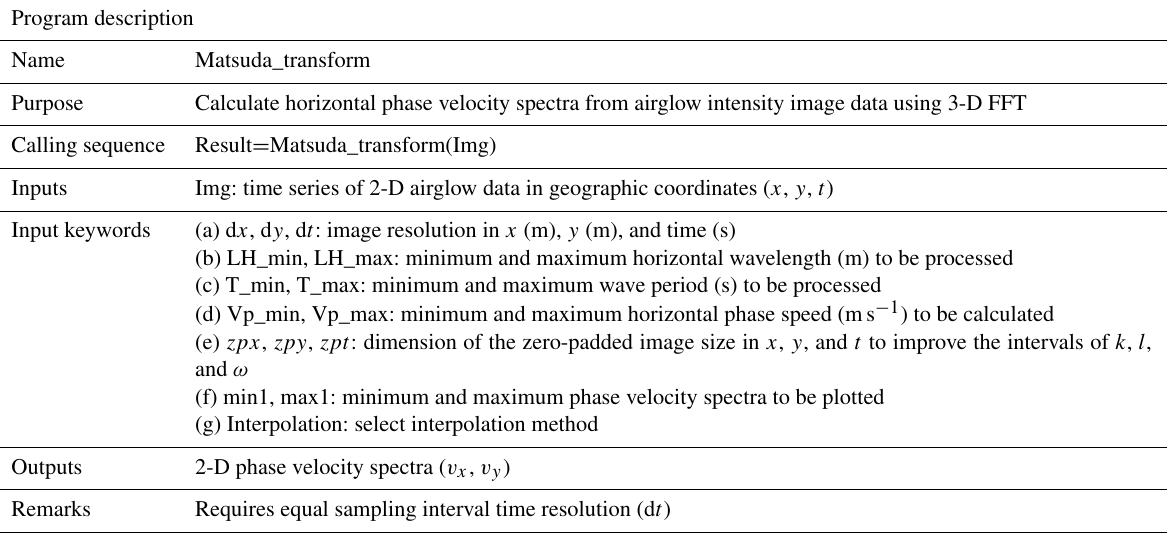
Table 1. Description of M-transform function on IDL.